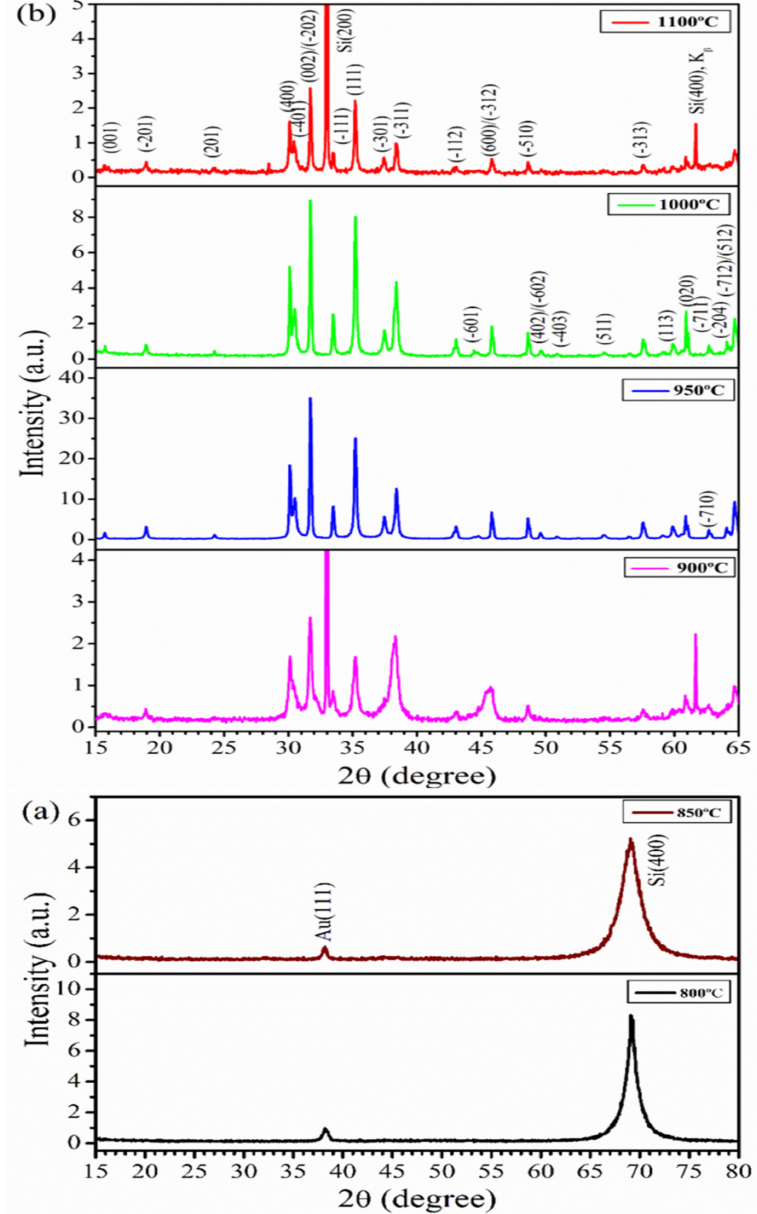
Figure 2. XRD patterns of β -Ga 2 O 3 nanostructures grown at different temperatures of ( a ) 800 and 850 ◦ C in the 2 θ range of 15–80 ◦ , and ( b ) 900–1100 ◦ C in the 2 θ range of 15–65 ◦ under a constant Ar flow of 50 sccm for 32